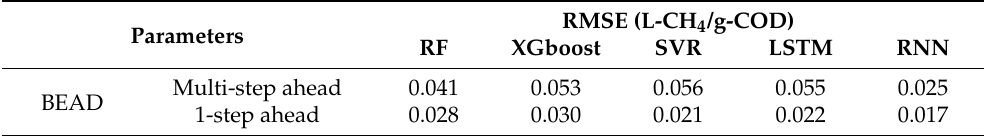
Table 3. RMSE values of BEAD reactor for multi-step ahead and 1-step ahead predictions using various machine learning models. Parameters